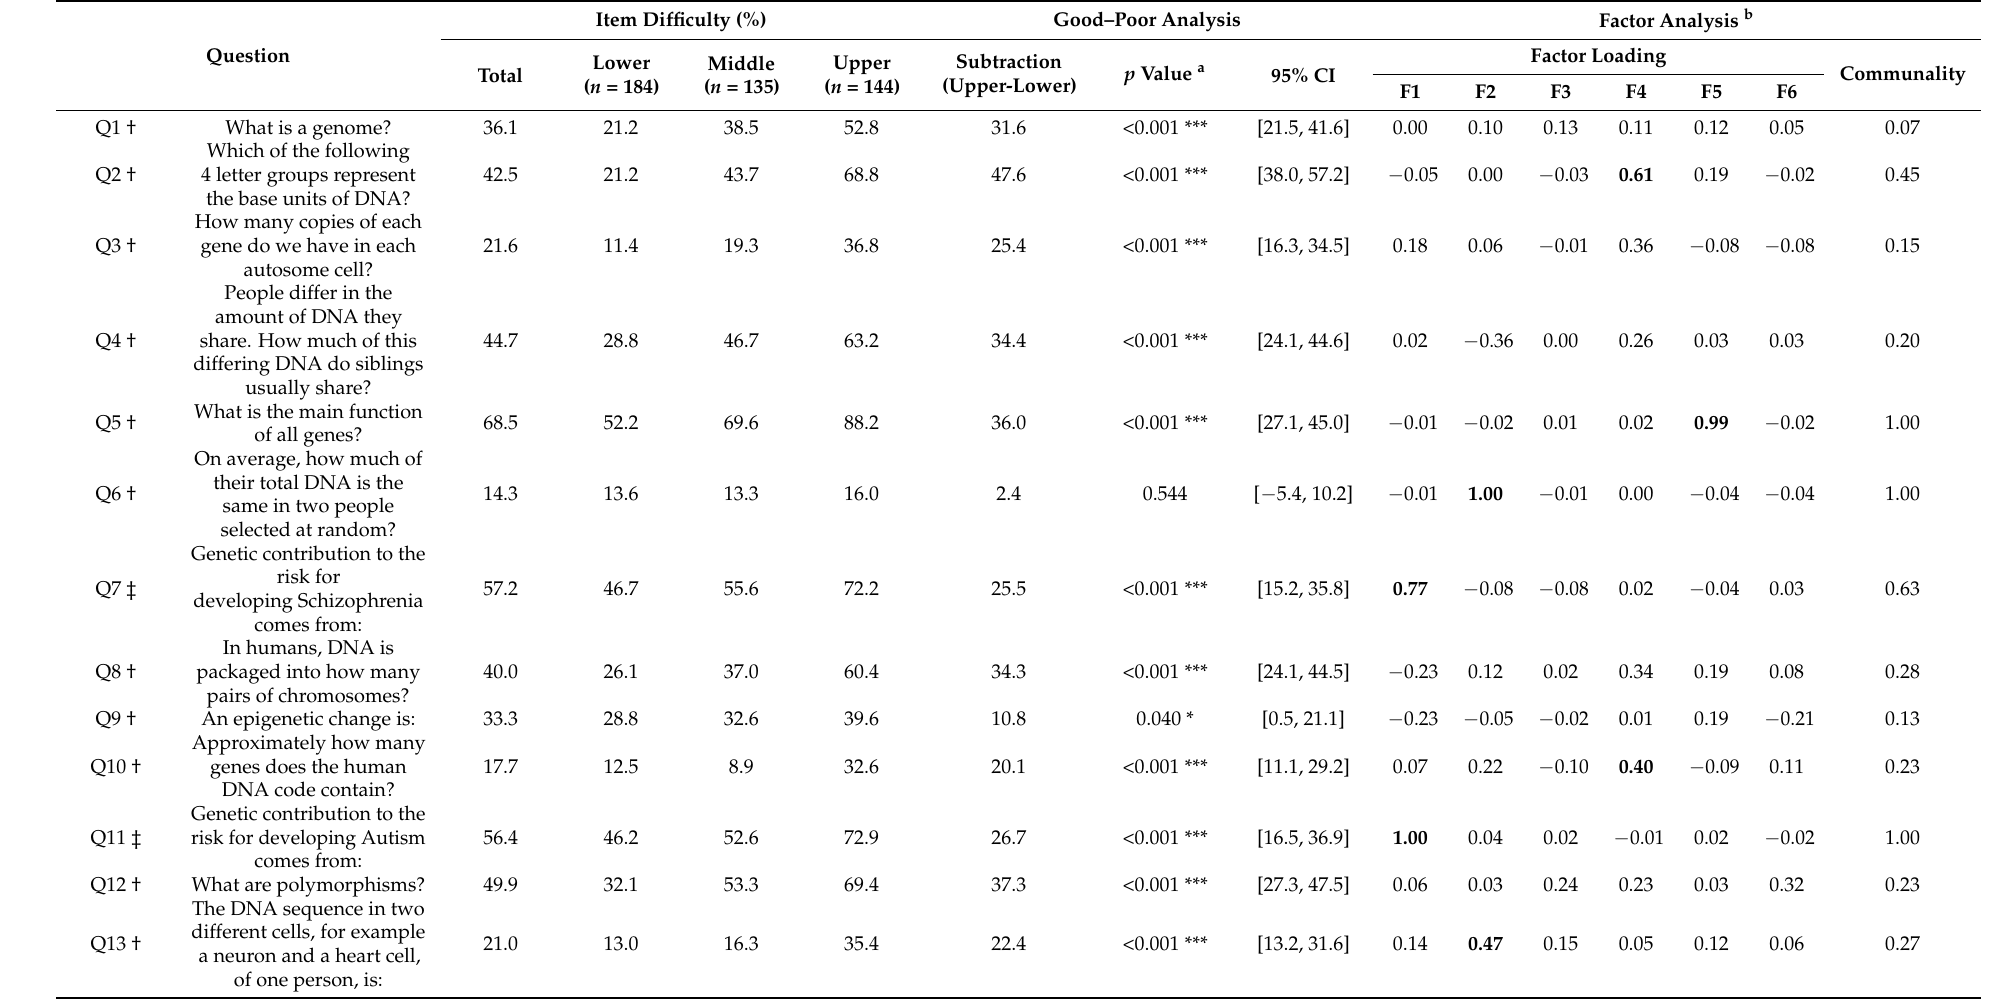
Table 1. Item analysis and factor analysis of Japanese version of